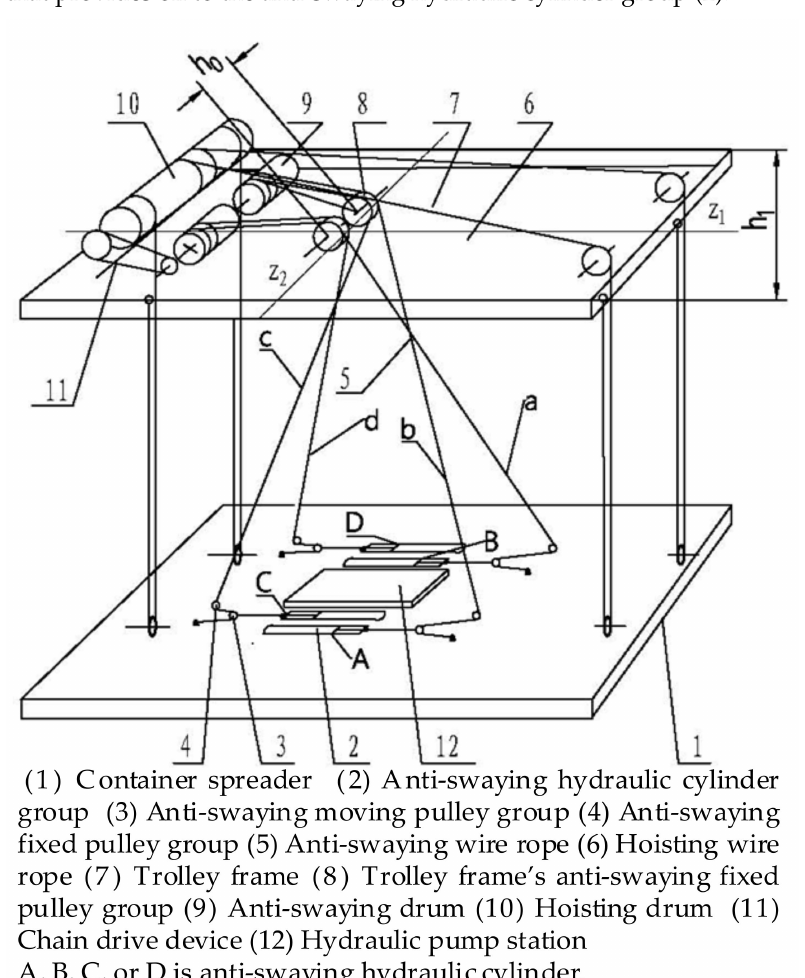
Figure 1. The mechanical structure of the hydraulic anti-swaying system. Four anti-swaying hydraulic cylinders, A, B, C, and D are symmetrically placed in the upper plane of the container spreader (1). Two of the trolley frame’s anti-swaying fixed pulleys (8) are symmetrically placed in the upper plane of the trolley frame, and their symmetry axes are z 1 and z 2 of the trolley frame (7). The installation distance, h 0 , is far less than the transverse size, h 1 , of the trolley frame, that is, h 0 << h 1 . As shown in Figure 1, the running direction of the trolley is the longitudinal direction of the hydraulic anti-swaying system. The anti-swaying wire ropes (5) are cross-connected to the anti-swaying fixed pulley group (4) on the spreader (1) through the anti-swaying fixed pulleys (8). The anti- swaying drum (9) rotates synchronously with the hoisting drum (10) through the chain drive device (11). The rotation of the hoisting drum (10) drives the rotation of the anti- swaying drum (9) so that the hoisting rope (6) and the anti-swaying wire rope (5) extend or shorten synchronously, thereby causing the hoisting load (together with the container) to ascend or